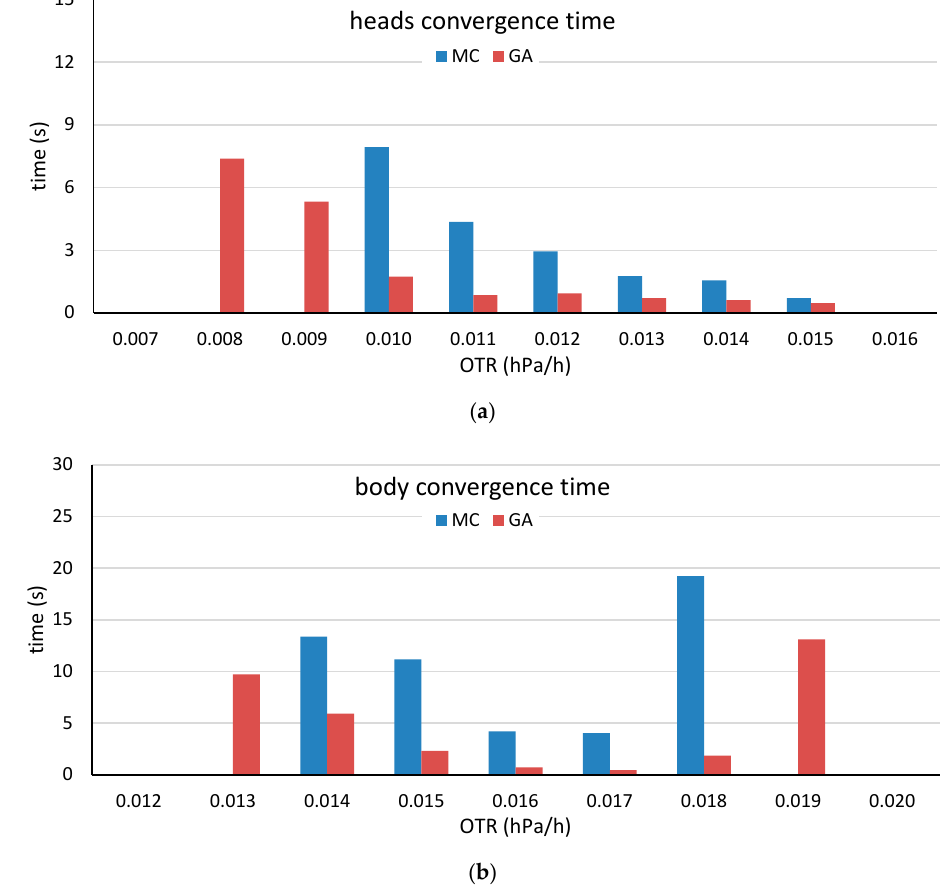
Figure 10. Mean convergence times of the for the head stave ( a ) and the body stave ( b ) by selection method for various target OTR values obtained by using the head and body low-OTR staves. The mean time was calculated with consideration of only the heads and bodies that were constructed before reaching the maximum iteration